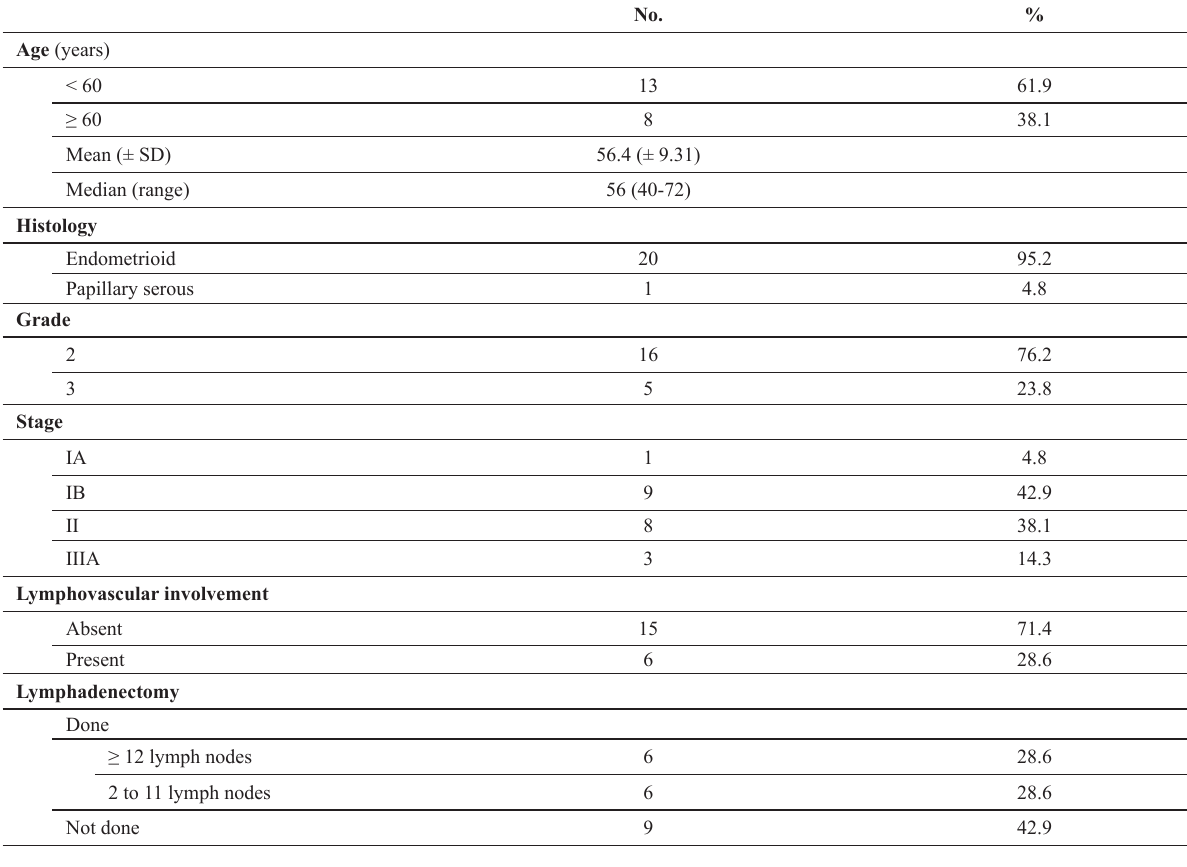
table 1: Patients' characteristics